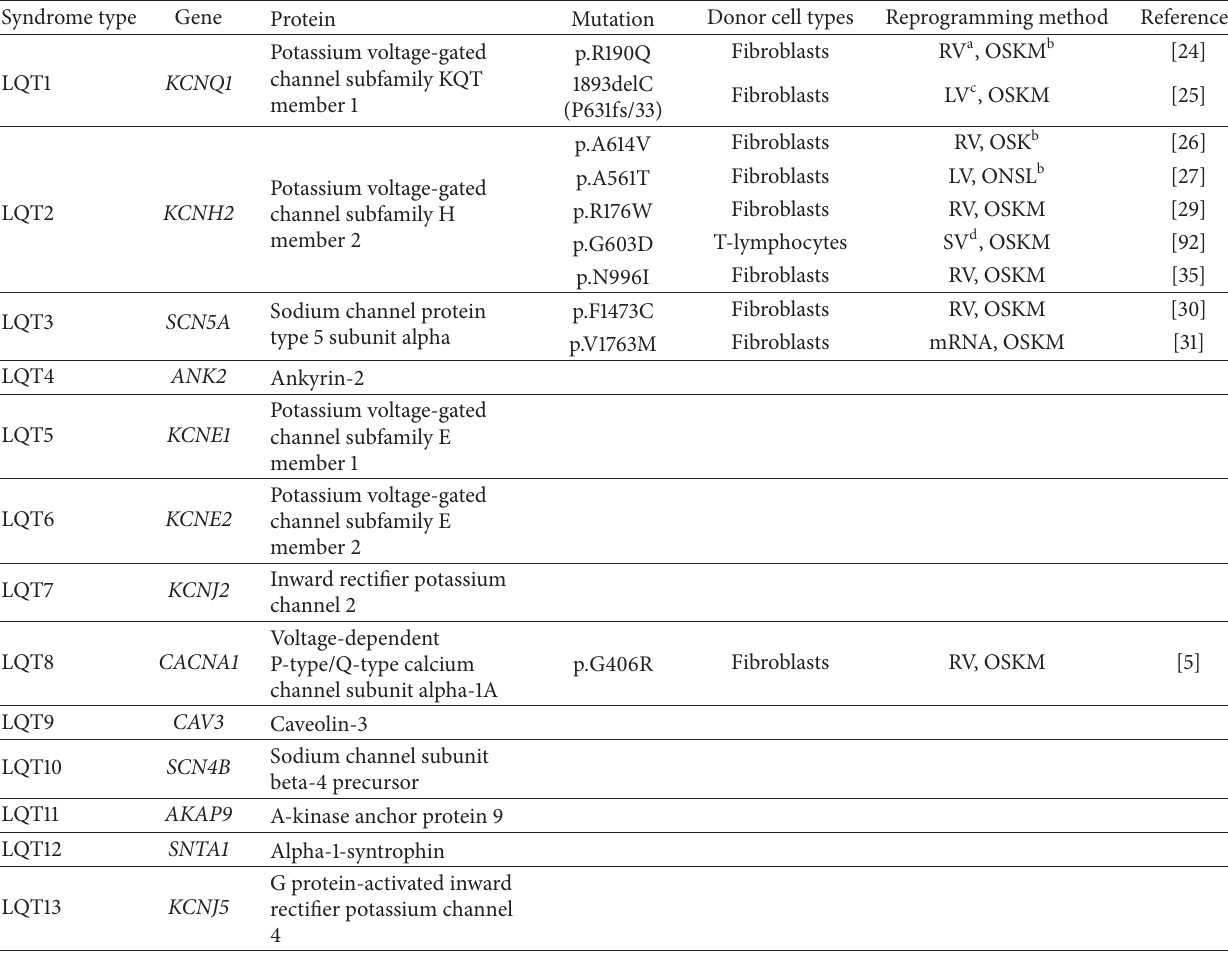
Table 3: Human IPSC-derived patient-specific LQT syndrome cell